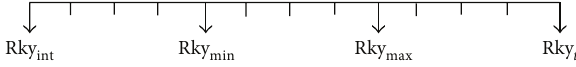
Figure 5: Rekeying time